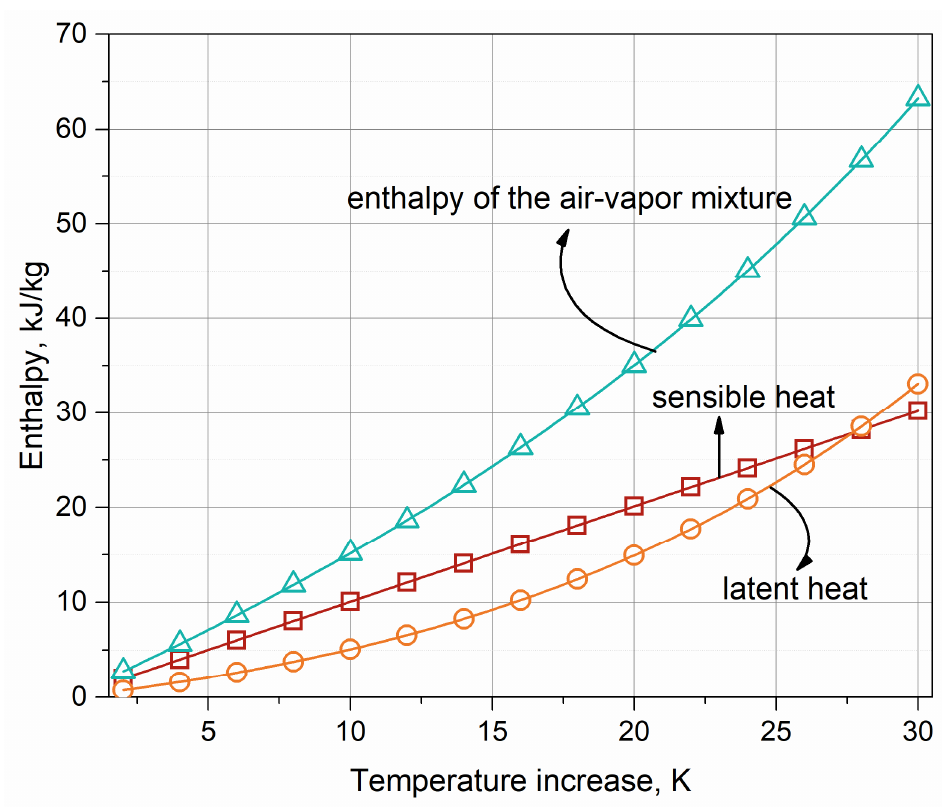
Figure 4. Relationships between dry bulb temperature increase and enthalpy of each part. The gap between the enthalpy of air-vapor mixture and dry air is widened with the increase in ambient temperature. In January, the airside parameters are shown in Table 8. Table 8. Detailed airside parameters of wet-mode, S3-mode of NDHC in January. Scheme